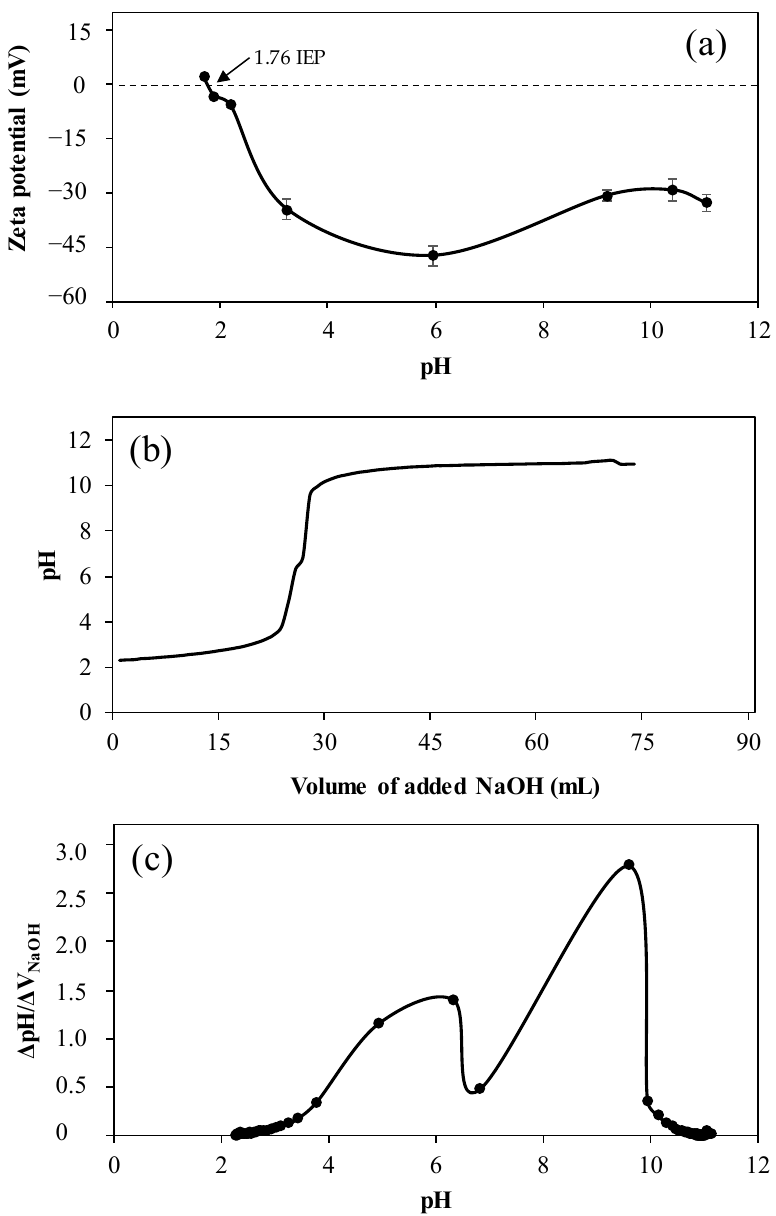
Figure 3. ( a ) Zeta potential measurements of p(Gly) particles at various pHs in 0.01 M KNO 3 solutions, ( b ) potentiometric titration of p(Gly) particles, and ( c ) the equivalence points of the reaction calculated from the derivative of the potentiometric titration.